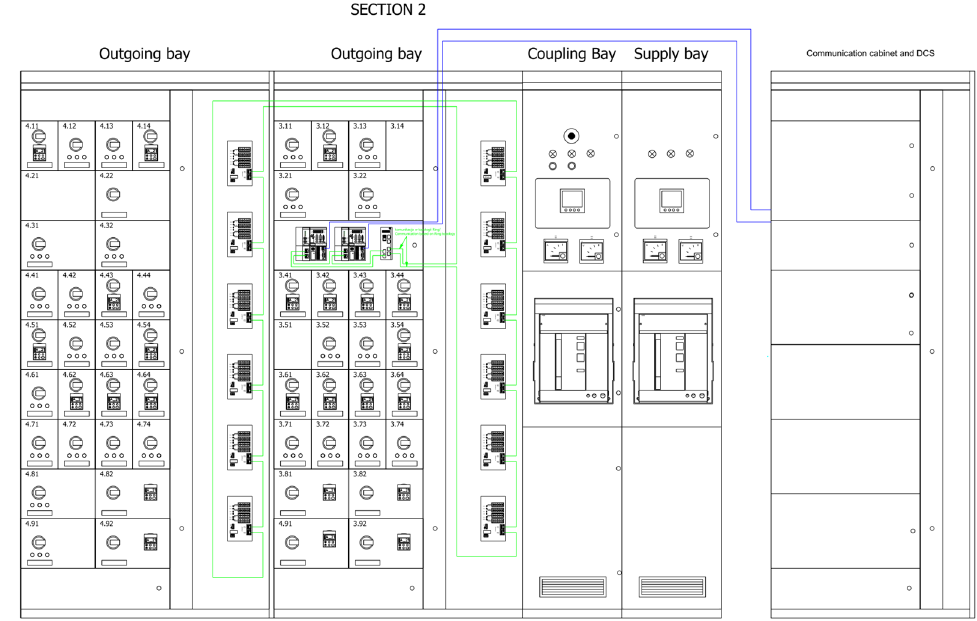
Figure 5. Detailed topology of the ring connection system in low-voltage switchgear based on two main PLCs, in order to maintain the highest system reliability (Section 2).